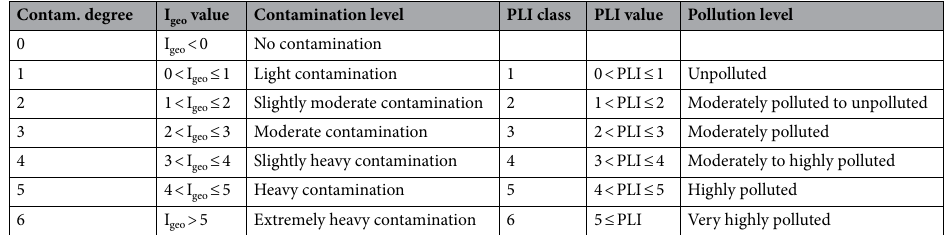
Table 7. Pollution load index 40 , Geo-accumulation index (I geo ) 58 . Contam. degree contamination degree.